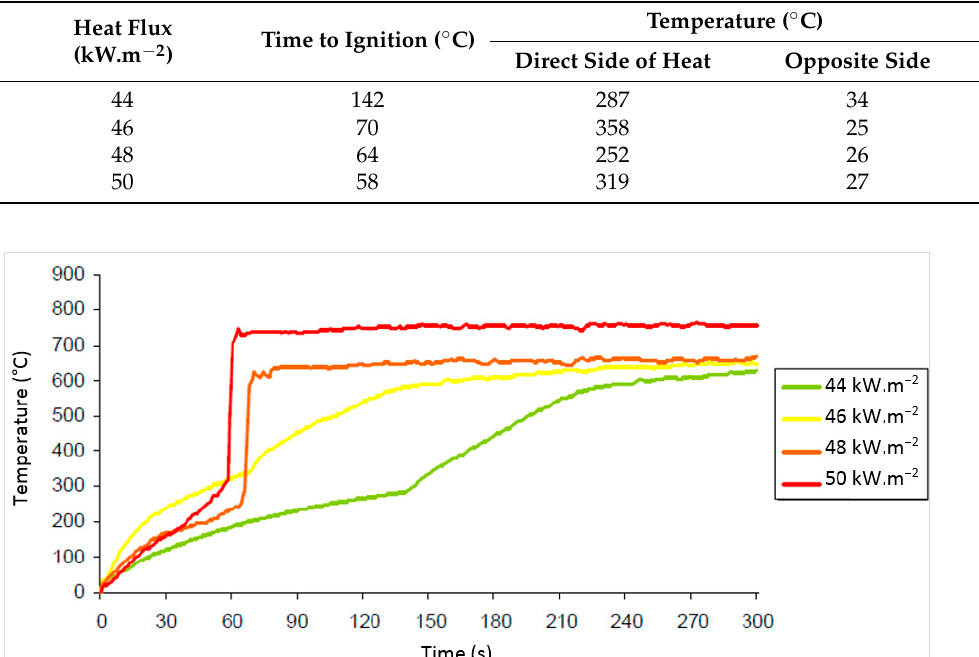
Table 7. Time-to-ignition and ignition temperature at the upper and lower surfaces of a 15 mm thick OSB sample corresponding to the individual radiant heat flux densities.